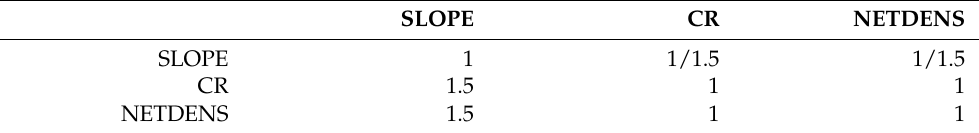
Table 3. The pairwise comparison matrix of the constant factors. SLOPE